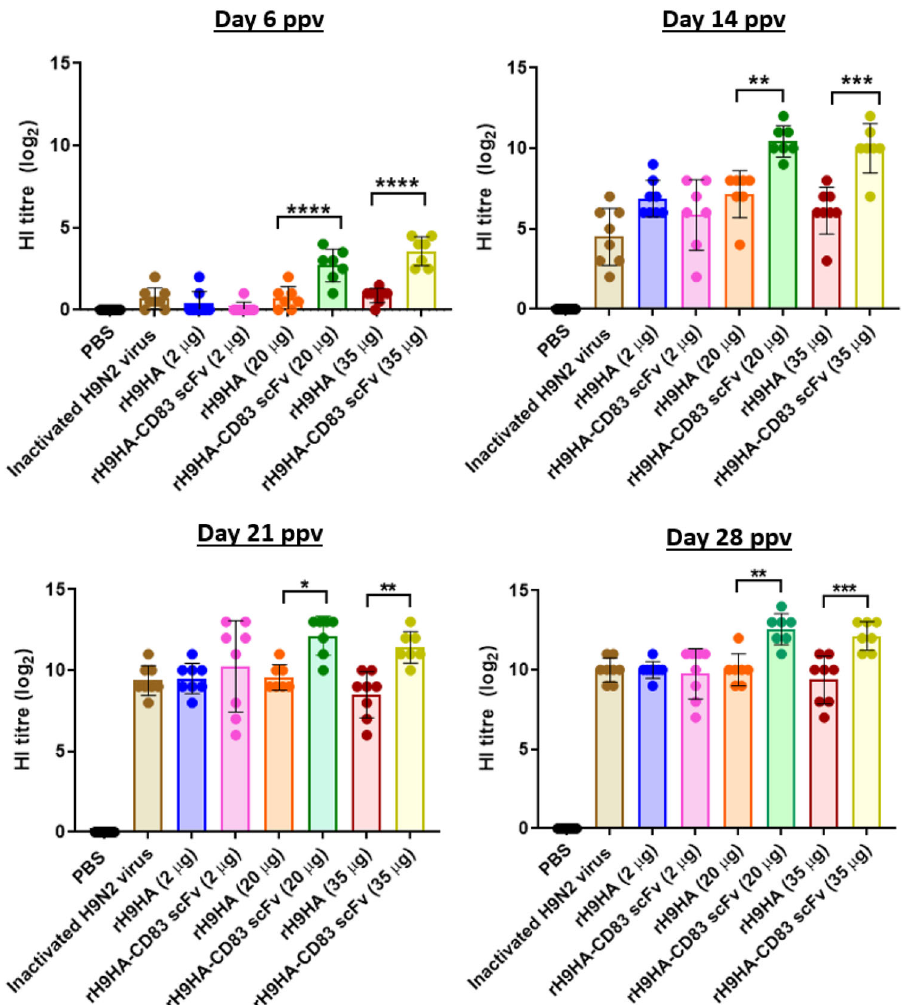
Fig. 5 Analysis of HI antibodies in the serum of chickens vaccinated with rH9HA, rH9HA-CD83 scFv, and inactivated H9N2 virus. Groups of 7 days old chickens ( n = 8) were immunised with 2.8, 28, and 49 µg of recombinant rH9HA-CD83 scFv equivalent to 2, 20, and 35 µg of recombinant rH9HA (equimolar concentration). Boost vaccination was given after 7 days post primary vaccination. The chickens were bled on day 6, 14, 21, and 28 posts primary vaccination. Antibody titres in sera were measured by haemagglutinin inhibition (HI) assay. The highest dilution of serum inhibiting the agglutination of RBCs by H9N2 virus (UDL01/08) was recorded. Data are presented as mean ± SD and analysed by one-way ANOVA followed by Tukey ’ s multiple comparison test. **** p < 0.0001 *** p < 0.001 ** p < 0.01 * p < 0.05. ppv post primary